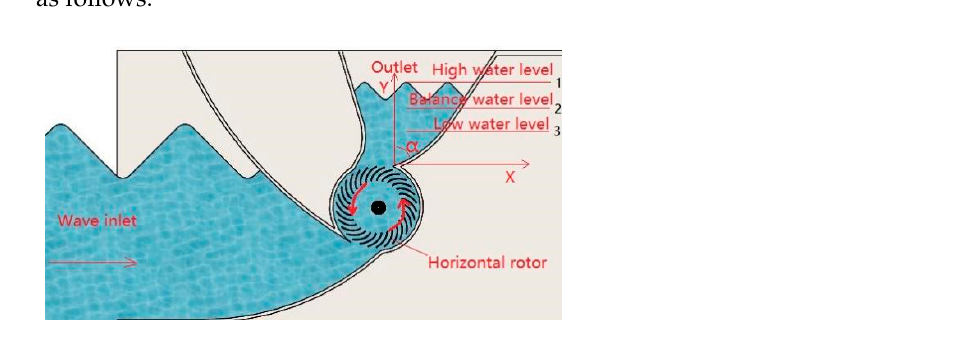
Figure 5. Cutaway view of the device.